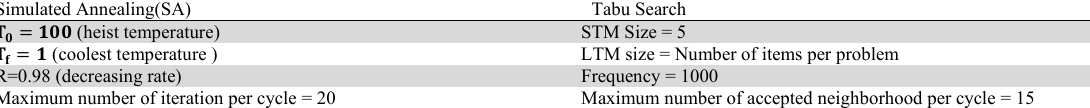
The initial parameter values for the algorithms Simulated Annealing(SA)